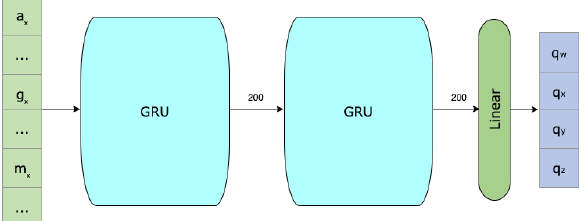
Figure 2. Structure of the 2-Layer GRU with 200 neurons per